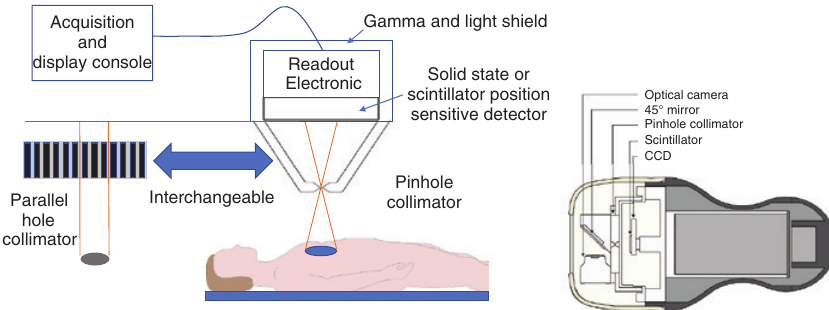
Figure 5: Intraoperative gamma imaging using a pinhole collimator. A mirror at the entrance of pin-hole collimator is used to reflect optical photons to the CCD camera and produce coregistered images of optical and gamma photons. Reproduced with permission from [71].